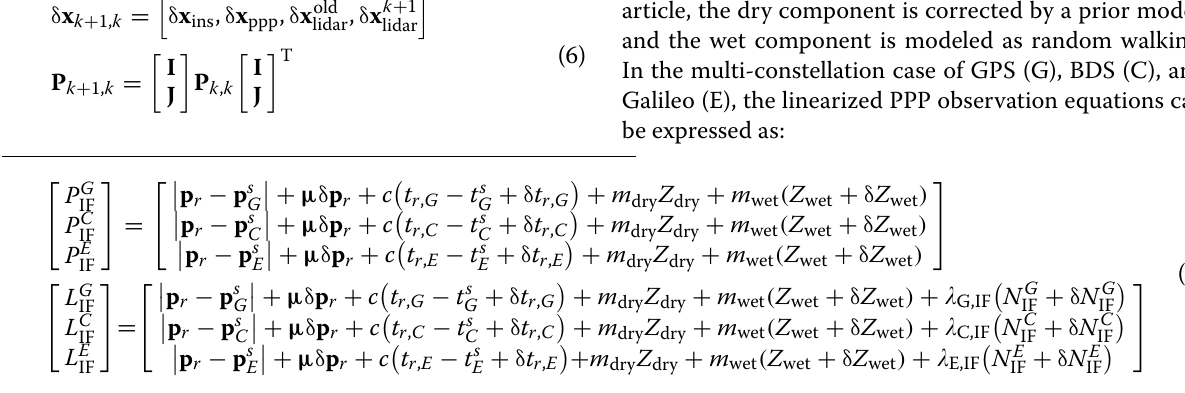
corresponding mapping